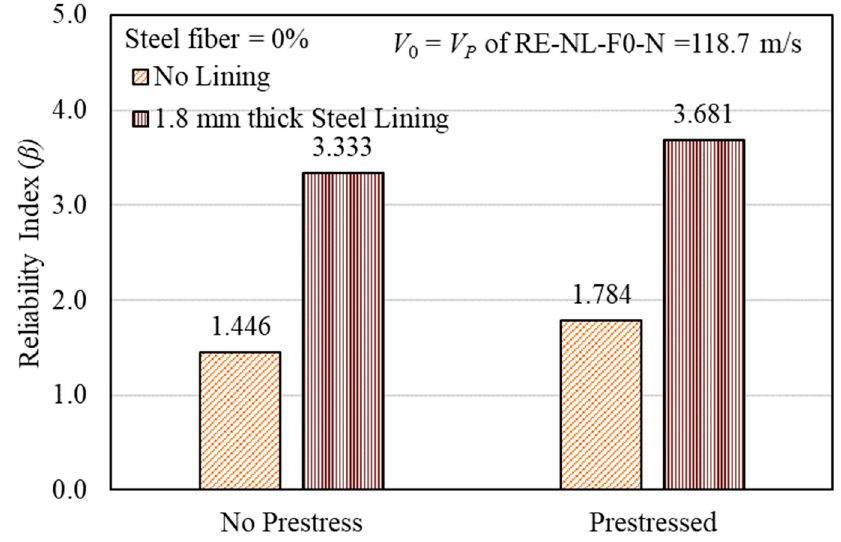
Figure 7. Effect of steel lining on the reliability of PFRC slabs.